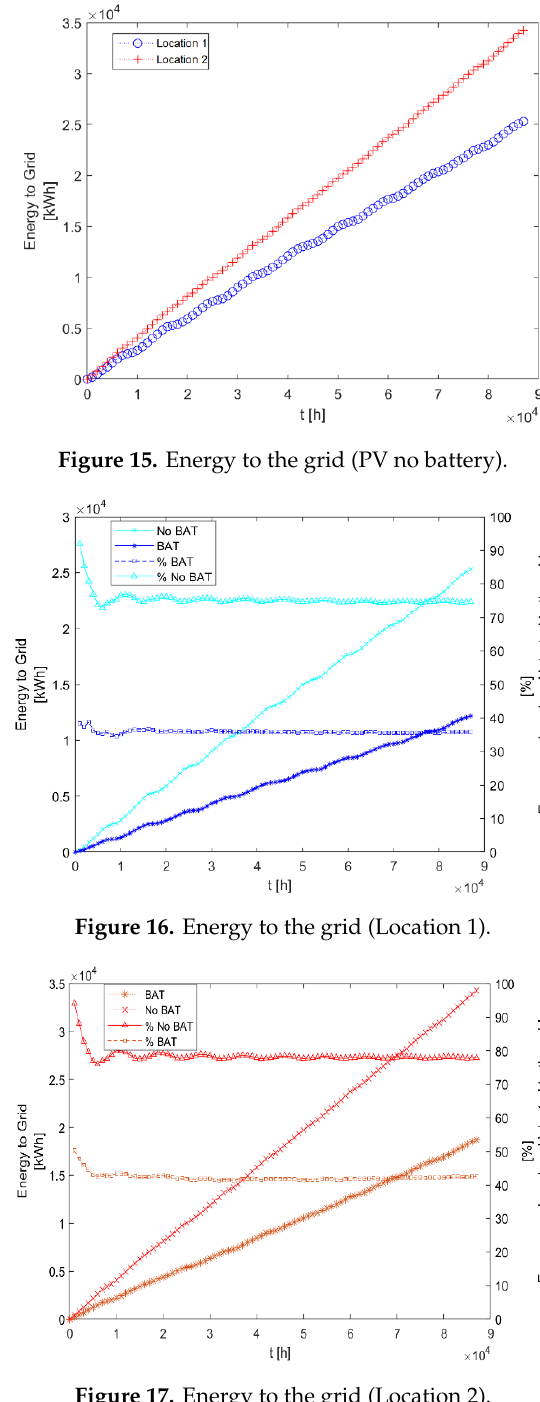
Figure 17. Energy to the grid (Location 2).